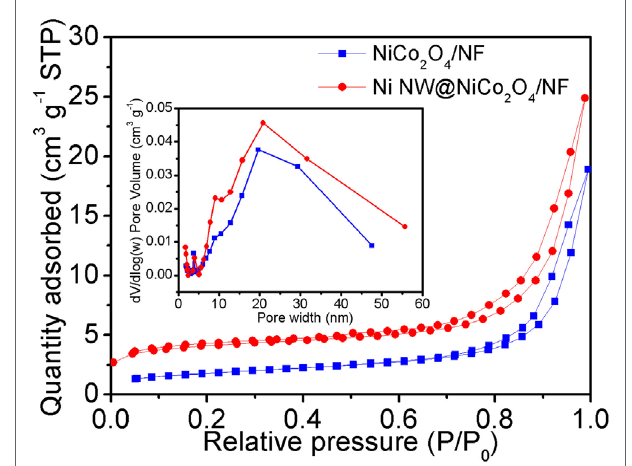
FigUre 4 | Nitrogen adsorption and desorption isotherms measured at 77 K for the NiCo 2 O 4 /NF and NiNW@NiCo 2 O 4 /NF. The inset shows the corresponding Barrett–Joyner–Halenda (BJH) pore size distributions.